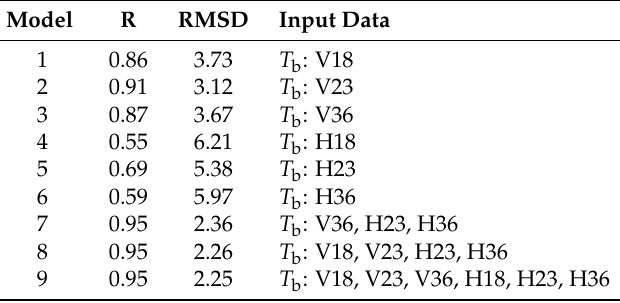
Figure 3. Scatter plot of the soil temperature retrieved with the neural network using T b H at 23 GHz and both T b H and T b V at 36 GHz (Model 7 in Table 2) versus ERA-Land soil temperature in the first layer (0–7 cm). The scatter plot is represented as the density of points in a logarithmic scale. Table 2. Evaluations of the performances of different NNs using Advanced Scanning Microwave Radiometer Earth (AMSR-E) T b ’s as input to retrieve the soil temperature ( T ) as predicted by ERA-Land models. Column 1 shows the model label. Columns 2 and 3 show the Pearson correlation and the root mean square difference of the NN T with respect to ERA-Land T . Column 4 shows the elements of the input vector in terms of polarizations (H or V) and frequency bands (number in GHz). The correlation uncertainty due to the training is 0.01 (Section 4.1). Model